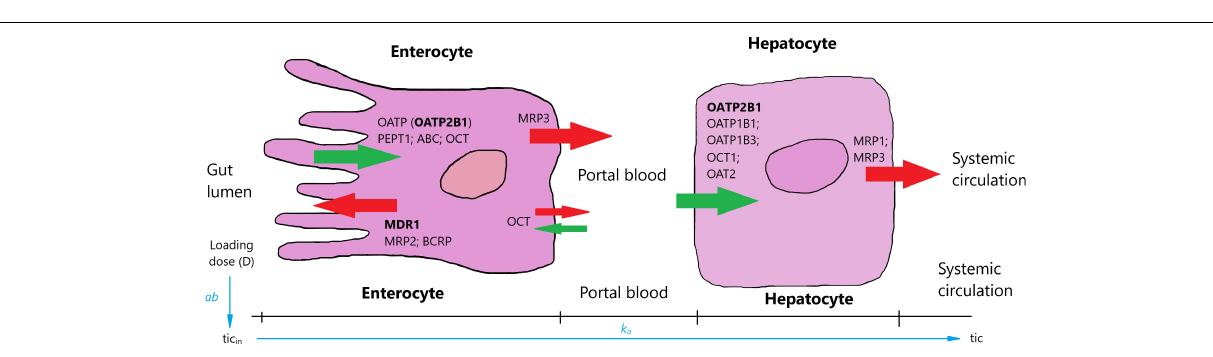
FIGURE 2 | Selected uptake (green arrows) and efflux (red arrows) transporters in enterocytes and hepatocytes [based on Giacomini et al. (2010) and Drozdzik et al. (2014)]. Ticagrelor is absorbed in the intestines and through portal blood gets to hepatocytes and further to systemic circulation. Transporters inhibited by ticagrelor are in bold. OATP, organic anion transporting polypeptide; PEPT1, peptide transporter 1; ABC, ATP-binding cassette transporter; OCT, organic cation transporter; MDR1, multi-drug resistance 1; MRP1–3, multidrug resistance-associated protein 1–3; BCRP, breast cancer resistance protein; OAT2, organic anion transporter